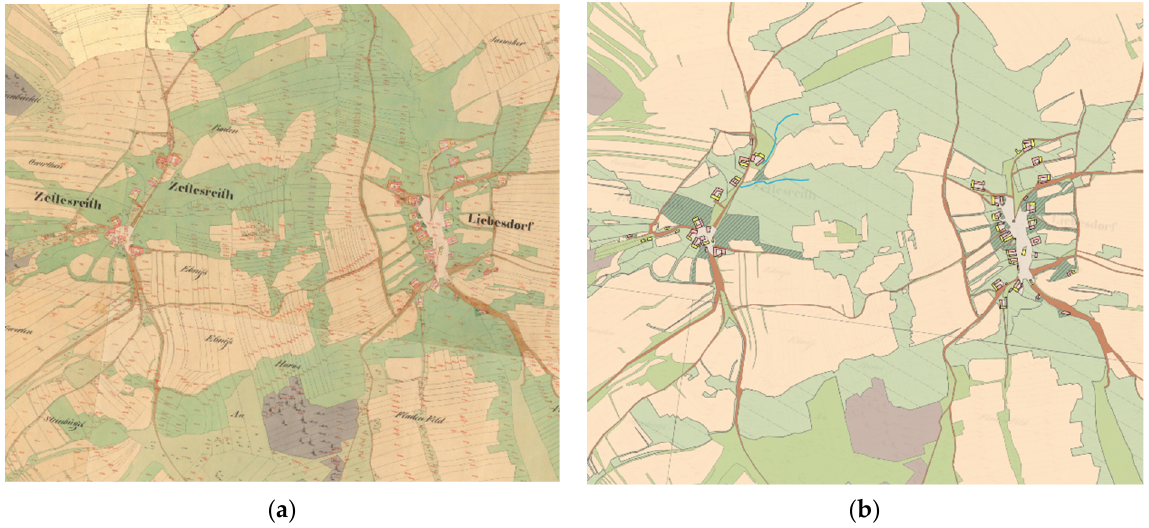
Figure 2. Imperial Obligatory Imprints of the Stable Cadastre 1:2880 : ( a ) example of a georeferenced scan of a map sheet used for vectorisation; ( b ) vectorisation of the map sheet shown in ( a ).